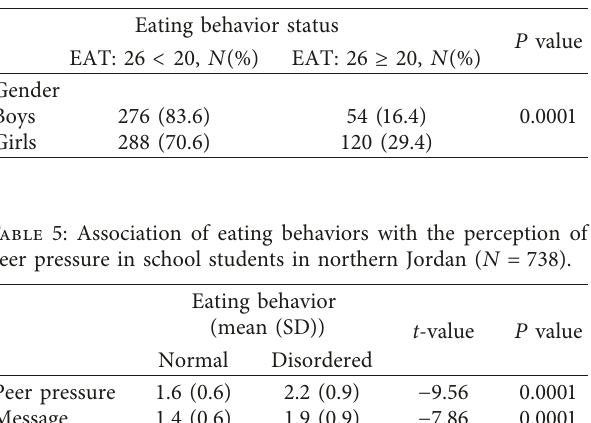
Table 4: Distribution of study participants by eating behaviors (EB) status and gender ( N �